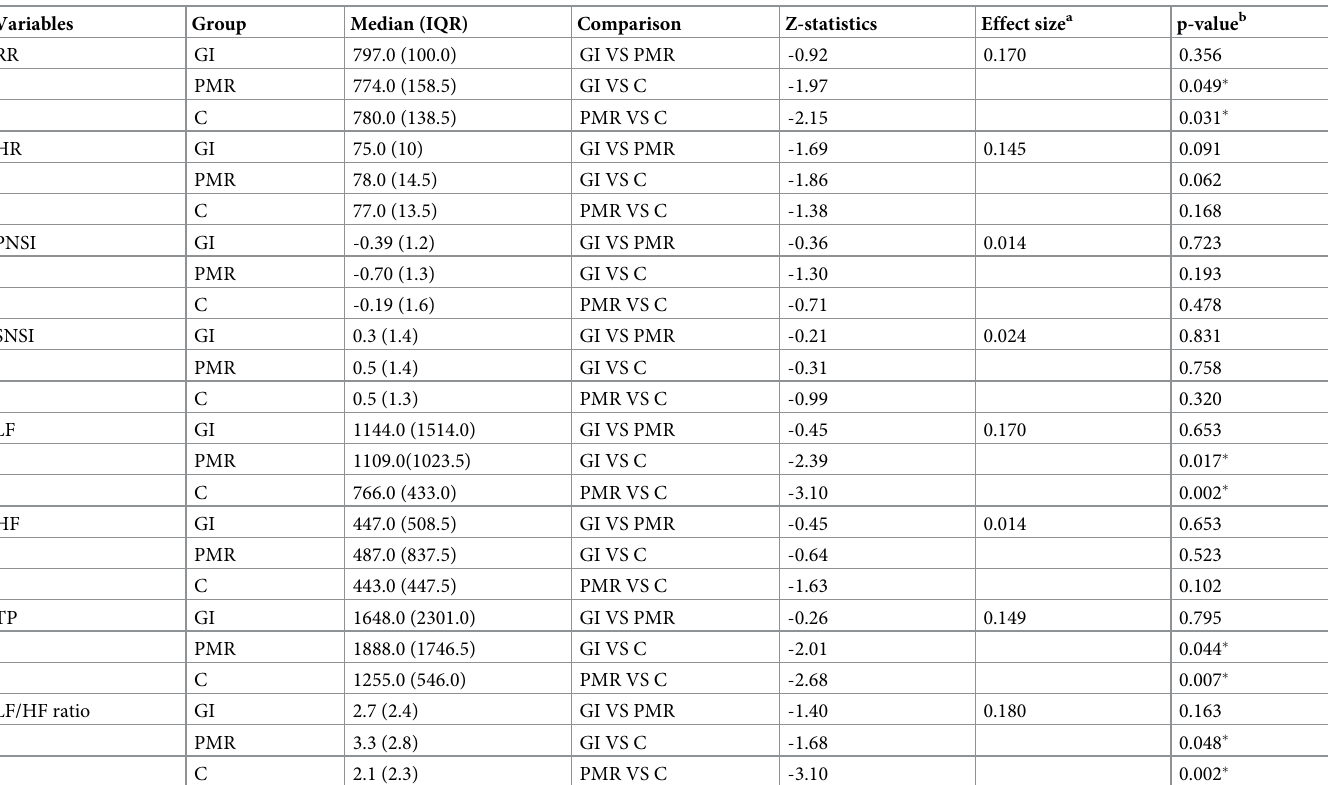
Table 3. Comparison of heart rate variables between guided imagery, progressive muscle relaxation, and control